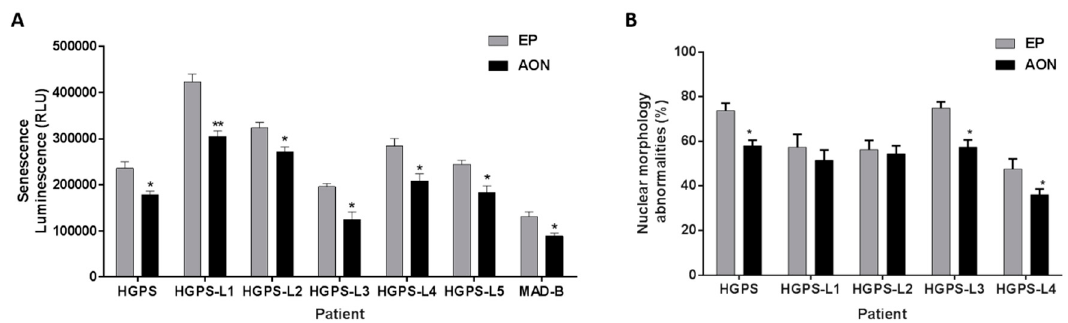
Figure 4. Antisense morpholinos reduce senescence in Hutchinson-Gilford Progeria Syndrome (HGPS), HGPS-like and Mandibuloacral Dysplasia type B (MAD-B) cell lines and improves nuclear shape abnormalities. ( A ) Senescence levels in HGPS, HGPS-like and MAD-B fibroblasts treated with antisense morpholinos (AON) for 10 days, relative to control, Endoporter-treated cells (EP). Senescence is determined as relative light units (RLU); bars show mean ± SEM, n = 3, Student’s t-test, * p < 0.05, ** p < 0.01). ( B ) The percentage of abnormal nuclei (nuclei with blebs, irregular shape, or multiple folds) of HGPS and HGPS-like fibroblasts treated with 20 µM of each antisense morpholino (AON) for 96 h, relative to control, i.e., Endoporter-treated cells (EP), was calculated using the Nuclear Irregularity Index (NII) plugin of the Image J Software. The mean values of three different experiments are shown. * p < 0.05.